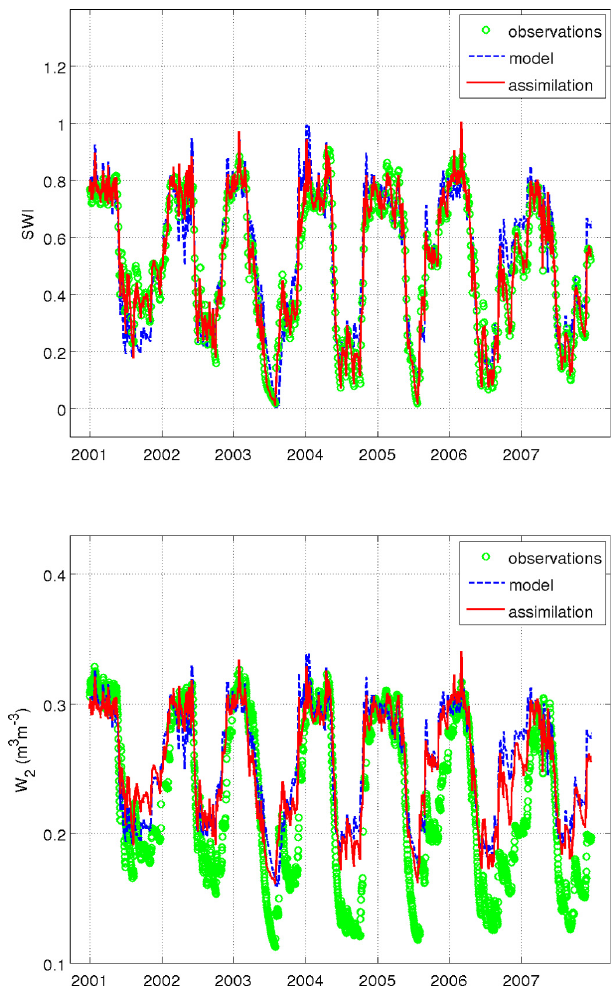
Fig. 3. Time series of observed, modeled and assimilated SWI (top) and soil moisture w 2 (m 3 m − 3 ) measured and modeled be- fore and after assimilation (bottom) of SWI from 2001 to 2007 for the SMOSREX